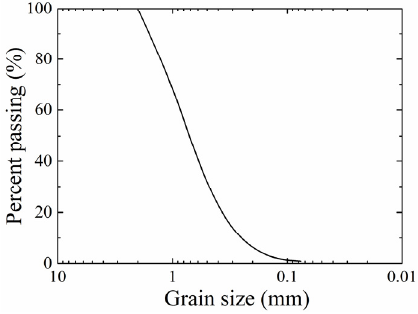
Figure 3. Particle-size distribution curve of the test sand.